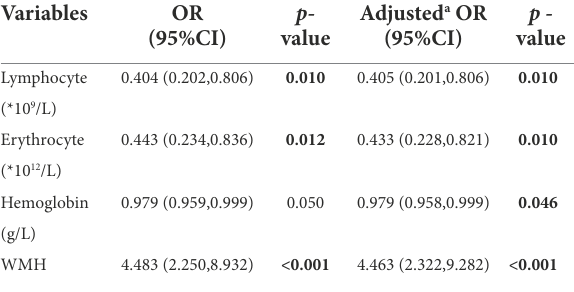
TABLE 2 Variate prediction of different cognitive groups with binary logistic